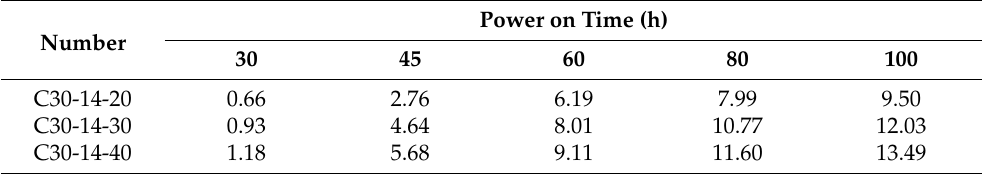
Table 3. Volume resistance loss rate of concrete under different voltages (%).